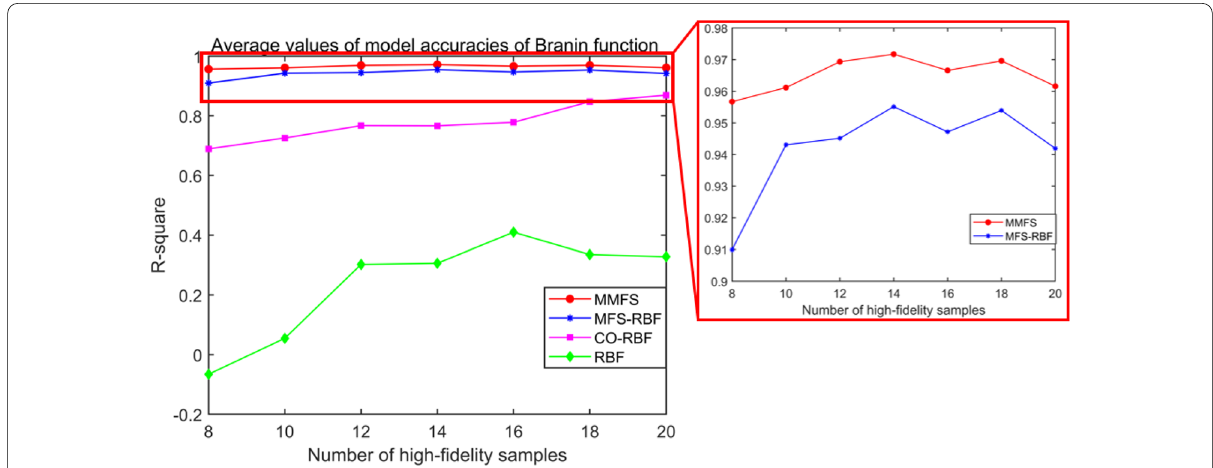
Figure 4 Average values of model accuracies of the Branin function